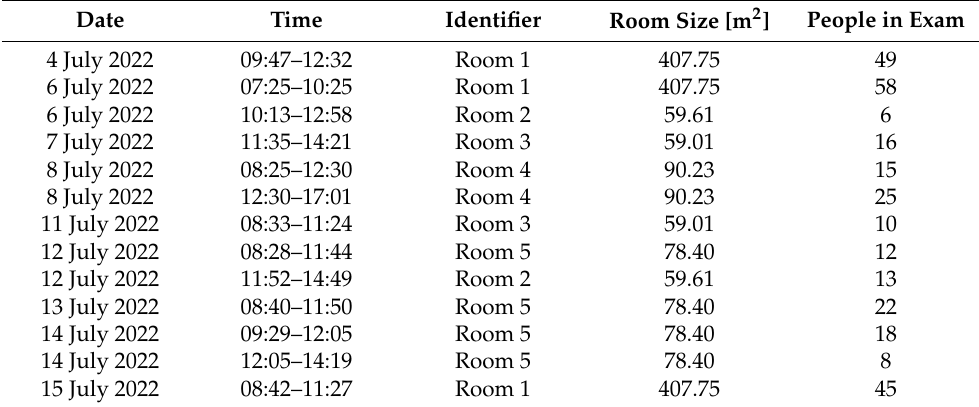
Figure 2. Recording structure in room 3. Table 1. Overview of recordings and room properties.